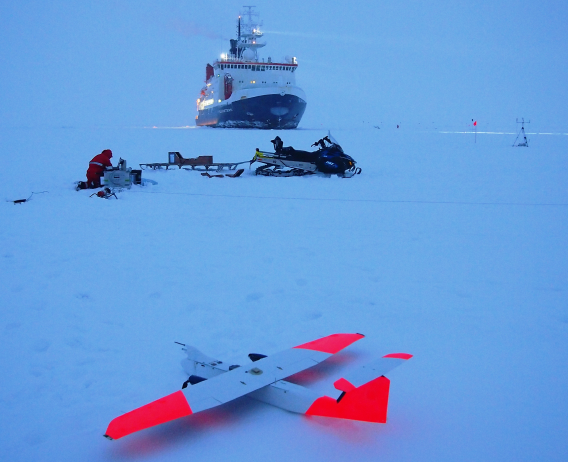
Figure 1. The M 2 AV in front of the RV Polarstern in the Weddell Sea on 11 July 2013. Photo: Andreas Scholtz, TU